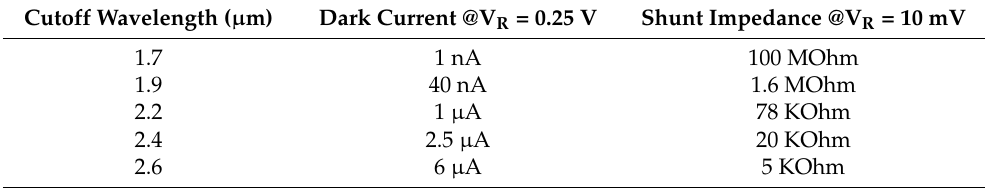
Table 1. Typical dark current and shunt resistance of the different photodiodes (1 mm diameter). Cutoff Wavelength ( µ m) Dark Current @V R = 0.25